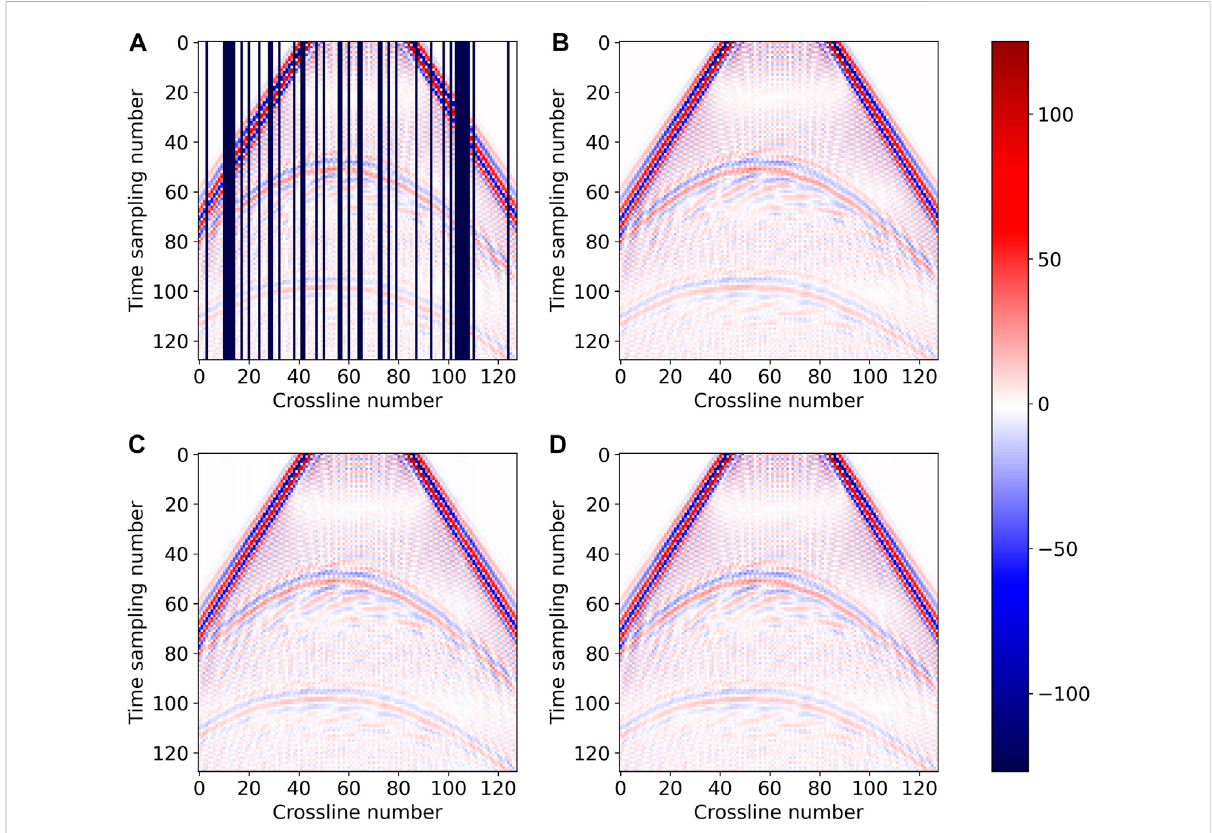
FIGURE 7 InlinesliceofinterpolationresultsontheSEGC3syntheticdata: (A) missingtracesdata; (B) groundtruth; (C) Unet(Chaietal.,2021);and (D) DS-